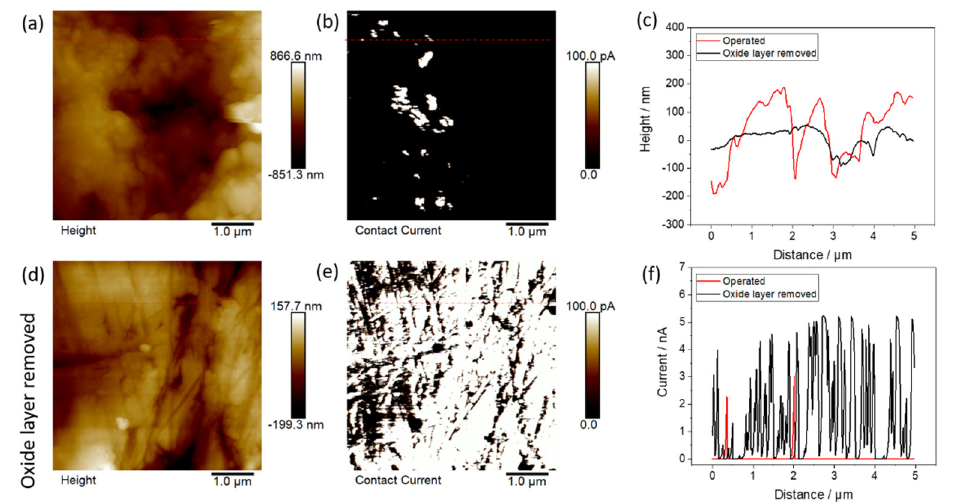
Figure 7. AFM measurements after corrosion tests of NbCu8L: ( a ) height of operated BPP, ( b ) electronic current of operated BPP, ( c ) height profiles of ( a , d ) as indicated by the red lines, ( d ) height of operated BPP (oxide layer removed), ( e ) electronic current of operated BPP (oxide layer removed) and ( f ) height profile of ( b , e ) as indicated by the red lines.